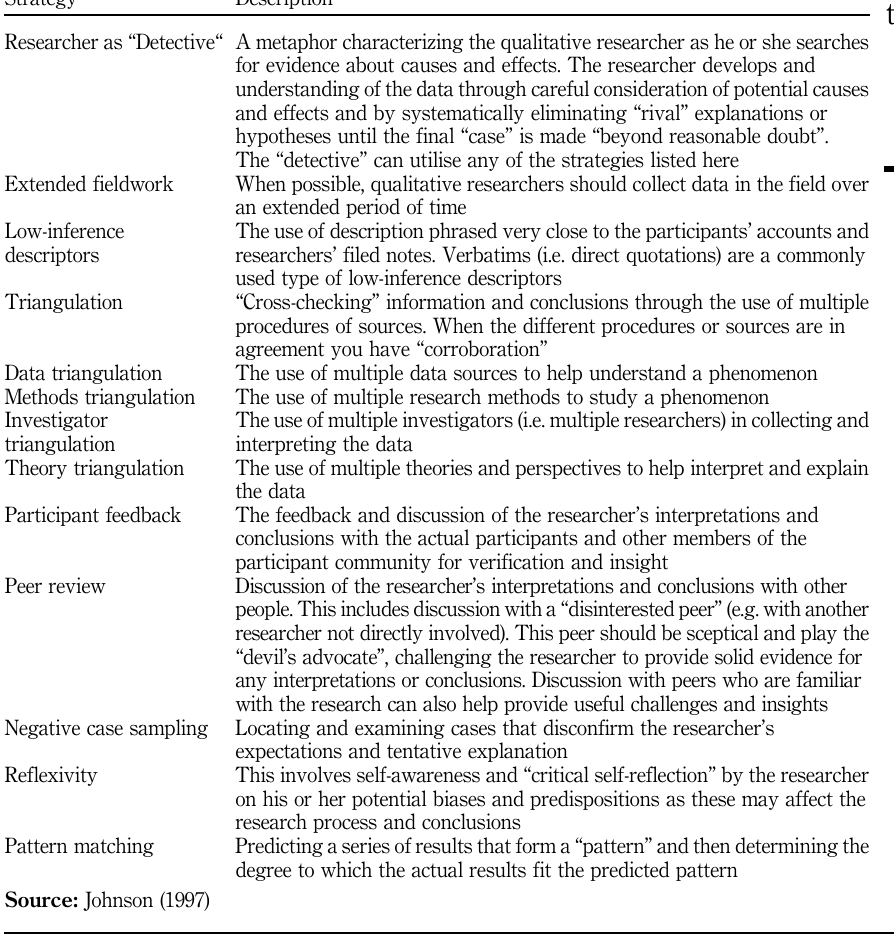
Table II. Strategies used